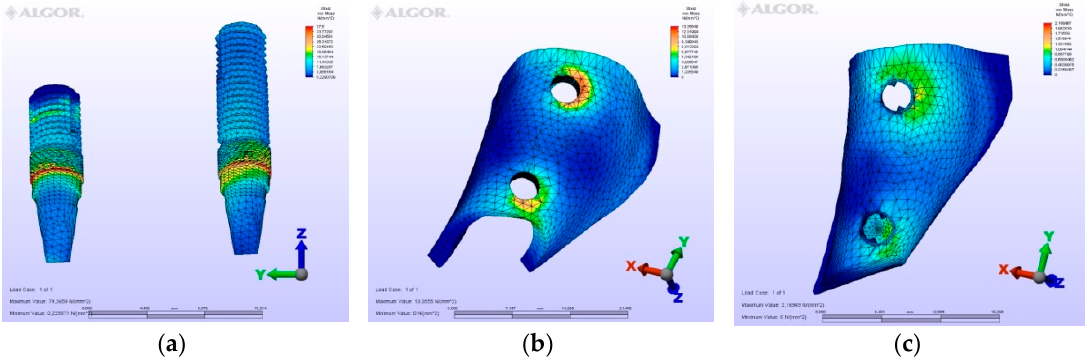
Figure 5. Model M2, axial loading. ( a ) the maximum von Mises stresses around implants; ( b ) maximum principle stress in cortical bone; ( c ) maximum principle stress in cancellous bone.